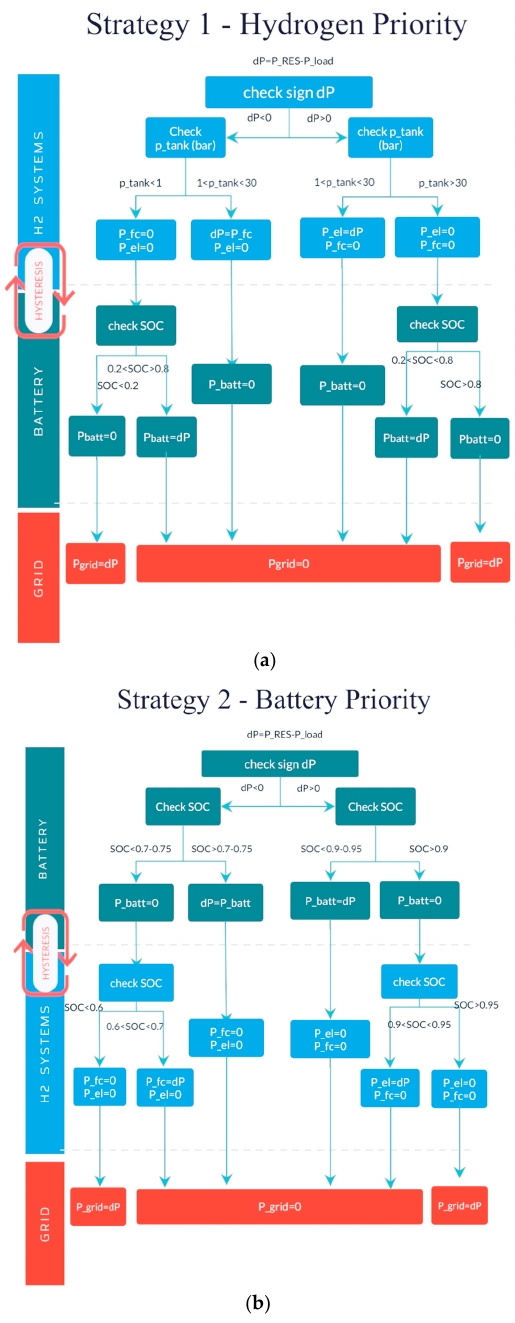
Figure 17. Hydrogen-priority strategy (a); battery priority strategy (b).